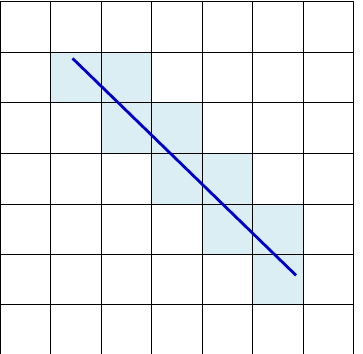
Figure 1. Schematic showing how to convert the dislocation line information into pixel image in binary format. The blue solid line is the dislocation